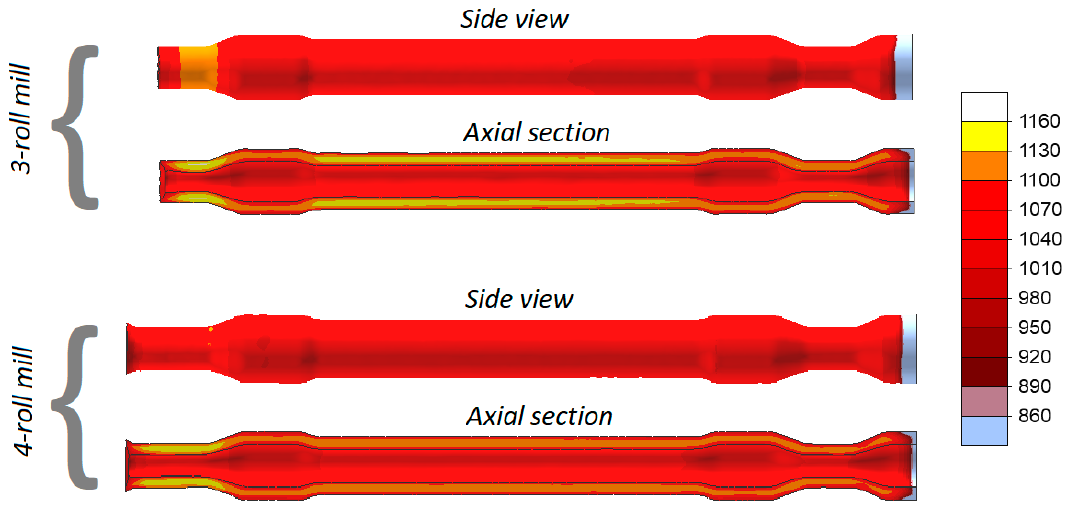
Figure 15. Temperature (°C) in skew-rolled hollow axles.